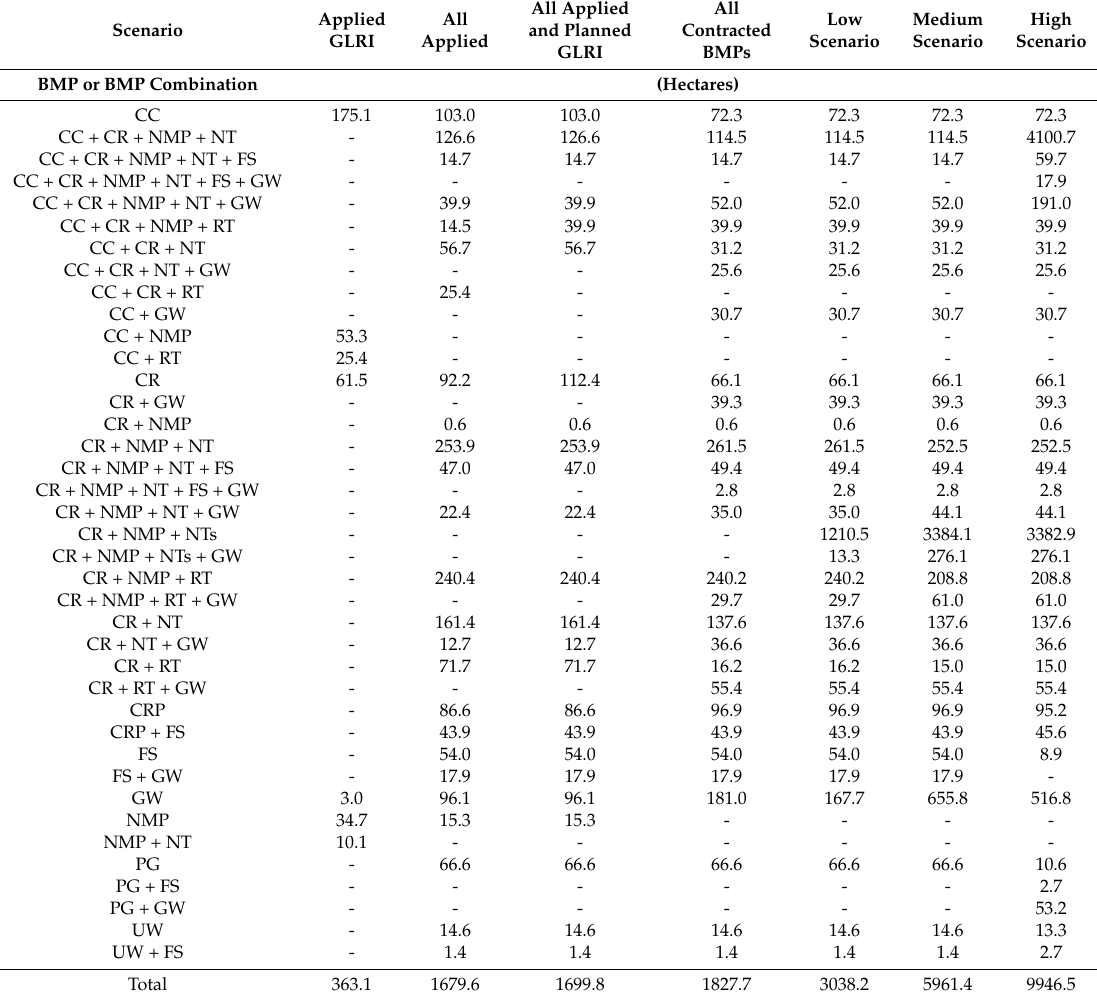
Table 5. BMP or BMP combinations by scenario investigated with the Eagle Creek watershed SWAT model,